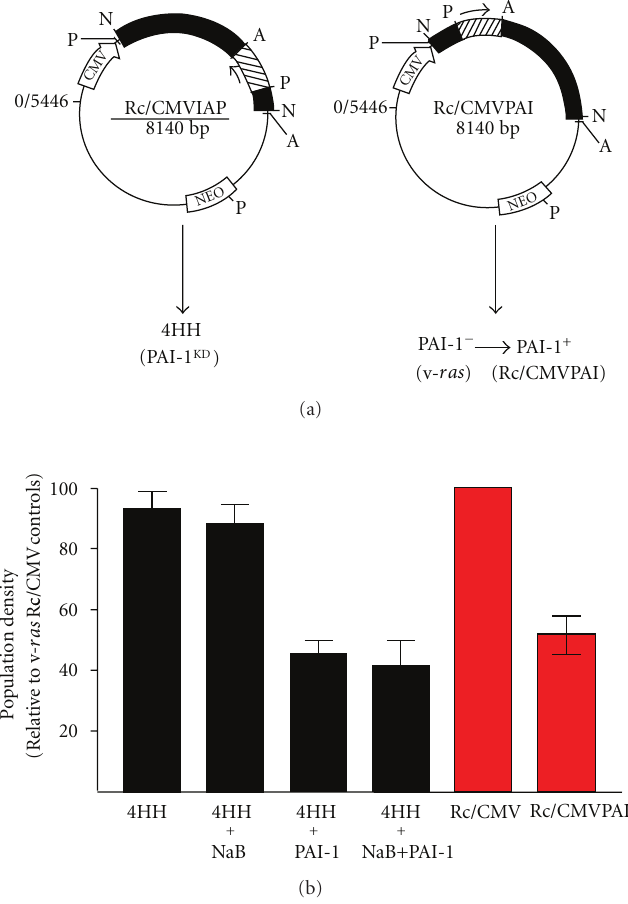
Figure 6: PAI-1 antisense and sense expression vectors were used to generate the PAI-1 knockdown (4HH; PAI-1 KD ) and overexpressing (Rc/CMVPAI) cell lines, respectively, (a). PAI-1-deficient 4HH cells were resistant to NaB-mediated cytostasis but remained sensitive to PAI-1-induced growth arrest. The combination of NaB+PAI-1 reduced final population densities similar to that of PAI-1 alone cultures (b). Vector-driven PAI-1 overexpression in v- ras transformants also inhibited cell growth consistent with results of the PAI-1 add-back experiments (e.g., Figure 5). Data plotted represents the mean ± standard deviation for triplicate assessments of final cell densities (i.e., %